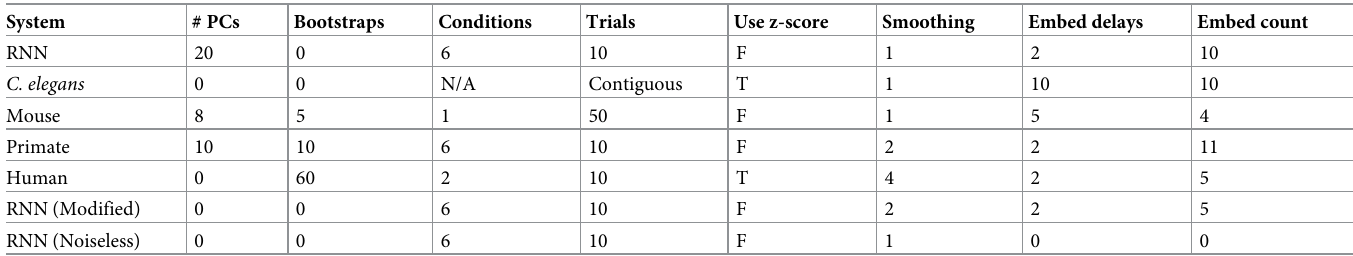
Table 1. Parameters used for preprocesssing.